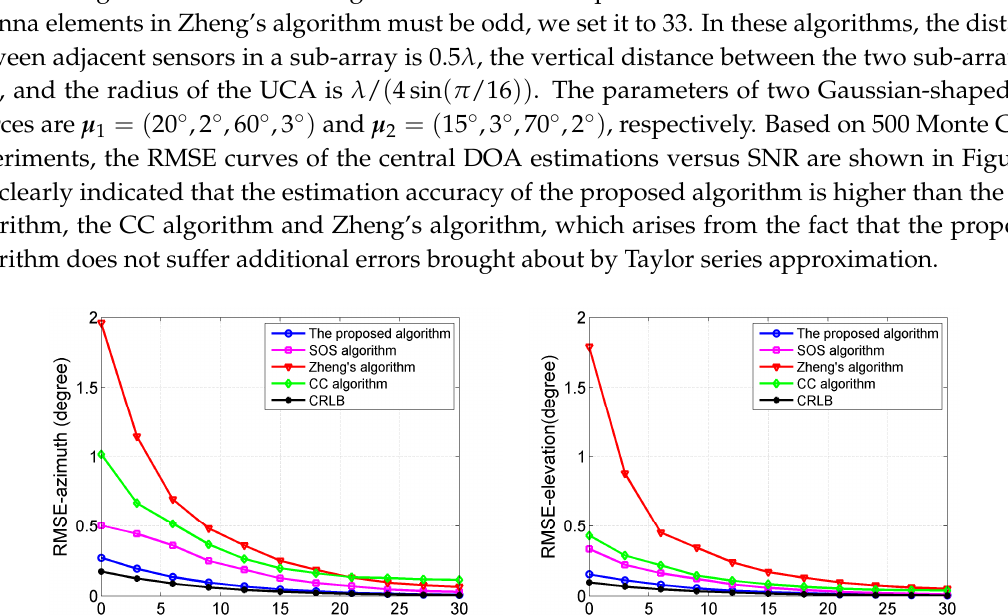
( b ) Figure 4. ( a ) RMSE curves of the central azimuth DOA estimations versus the number of snapshots; ( b ) RMSE curves of the central elevation DOA estimations versus the number of snapshots. 4.4. Effect of the Central Elevation and Azimuth DOAs In the last example, we examine the performance of the proposed method versus the central elevation and azimuth DOAs for a Gaussian-shaped CD source with